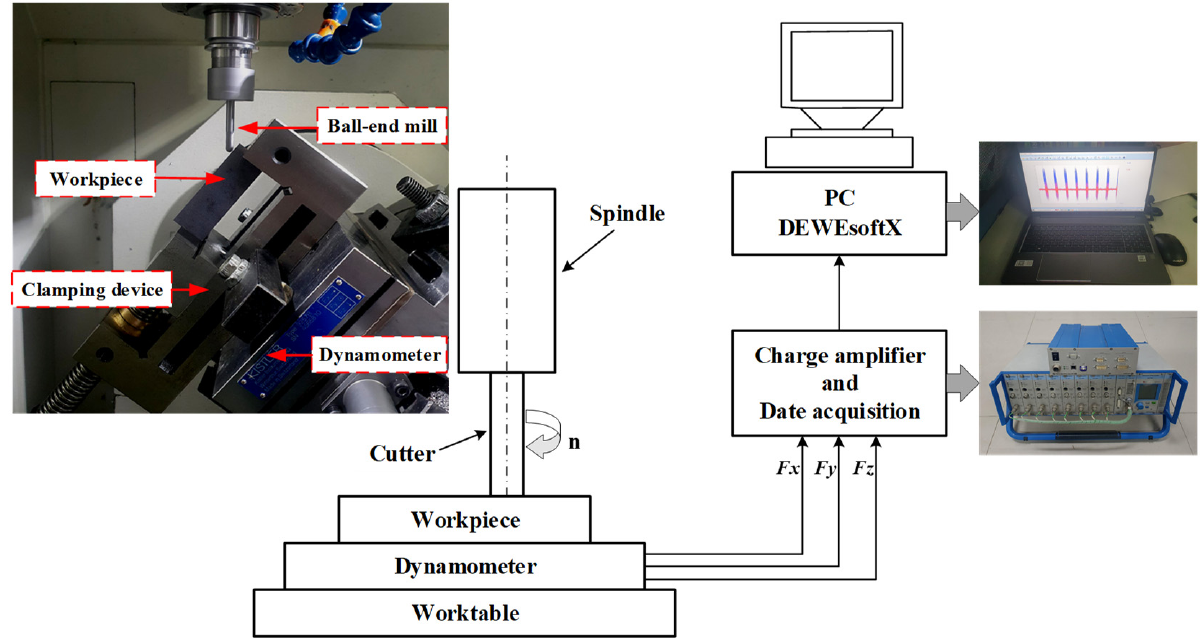
Figure 3. Schematic diagram of the multi-axis milling experiment.